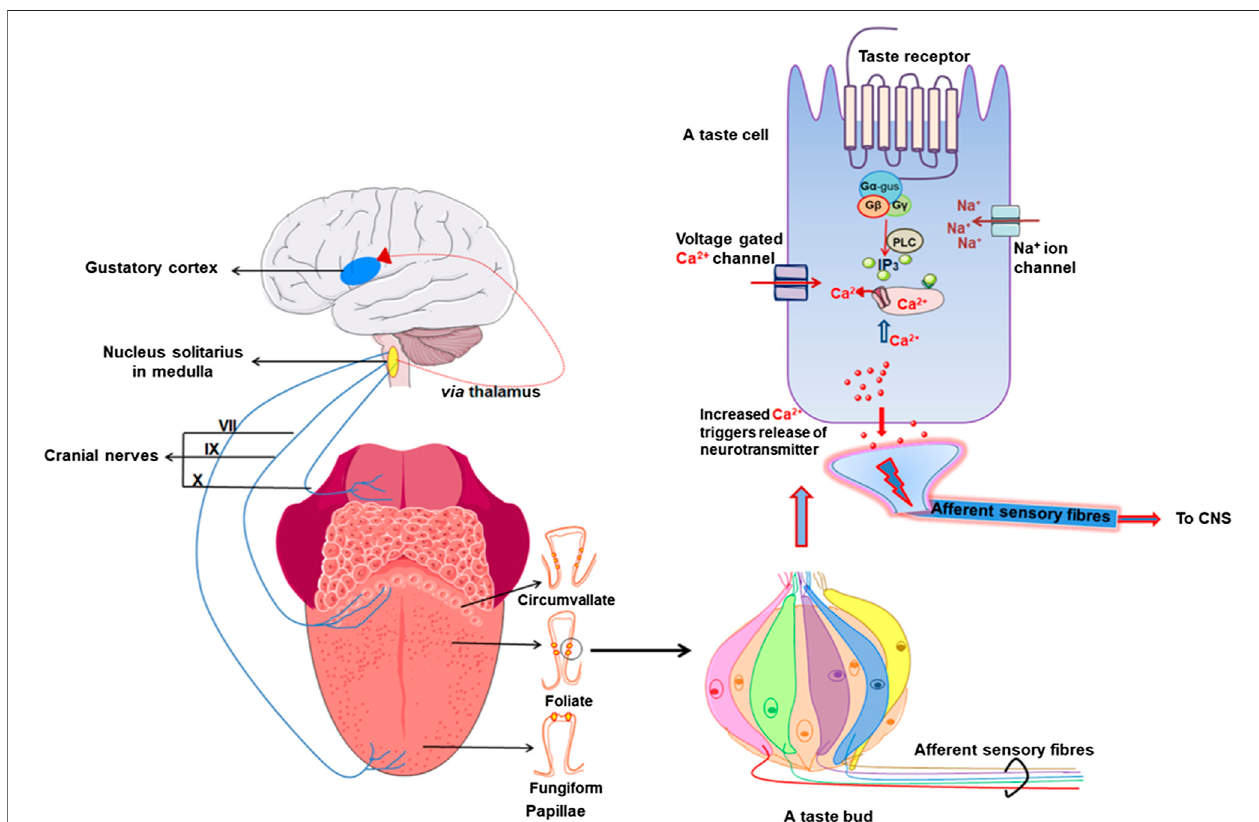
FIGURE 1 | Schematic diagram shows taste signal transmission between tongue and brain. Taste buds present in different papillae in tongue and palate contain tastereceptorcells(TRC)whichcontaintasteGprotein-coupledreceptors(GPCRs).Leftsideshowshowafferentnervestransmitasignaltothegustatorycortexinbrain via cranial/glossopharyngeal nerves. Right side shows taste bud with taste TRCs and simpli fi ed signal transduction pathway of taste receptor where taste GPCRs are activated by a tastant that in turn recruits a speci fi c G protein that further induces intracellular calcium release (created with BioRender.com).